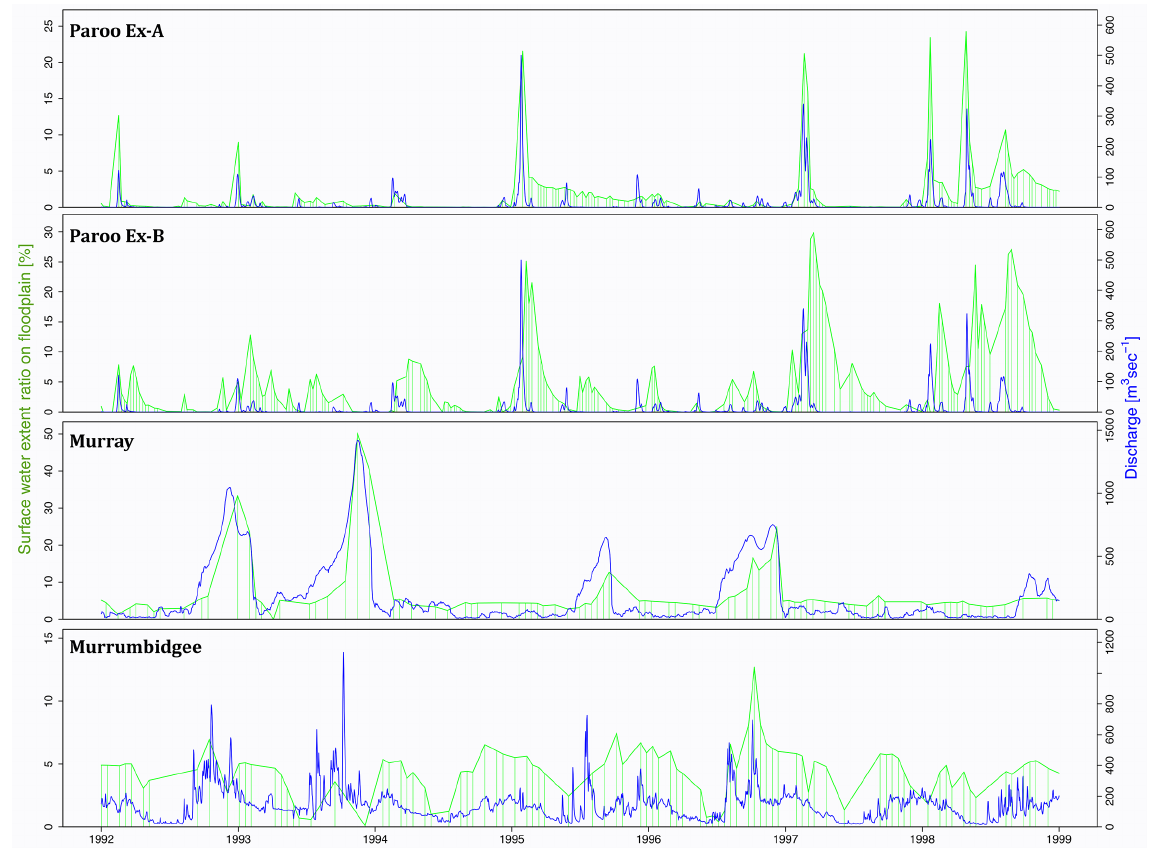
Figure 7. Time series of surface water extent ratio on floodplains and discharge in the corresponding river gauge for four example grid cells for the period from 1992 to 1999. (Vertical green bars indicate time steps of the SWE time series; location of example grid cells is shown in Fig. 3.)